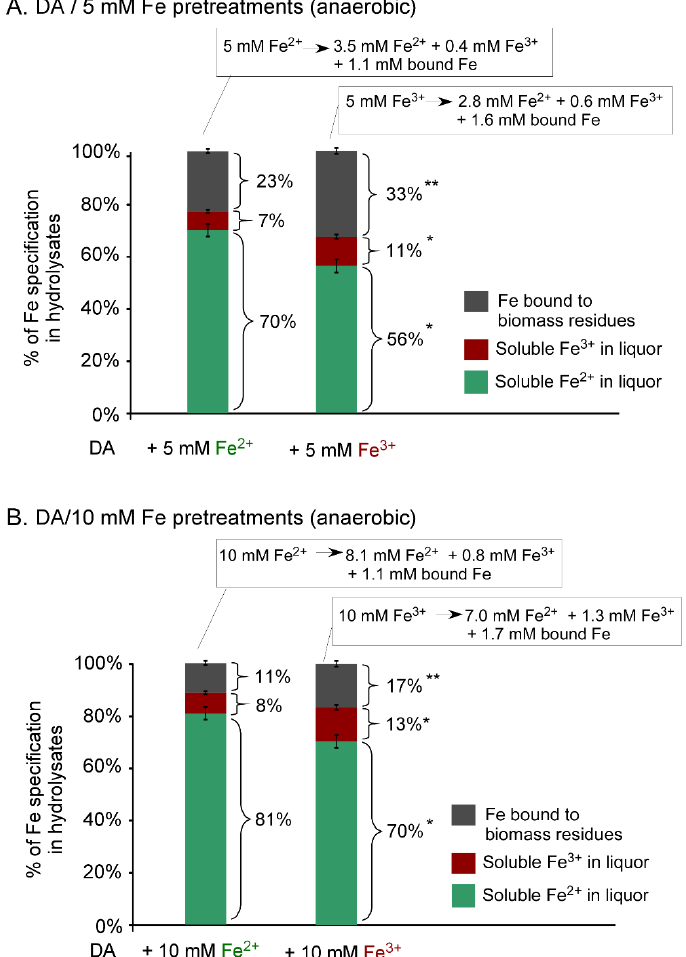
Figure 2. Fate of Fe in corn stover pretreated with either 5 or 10 mM Fe ions in dilute acid (0.5% H 2 SO 4 ) at 150 ◦ C for 20 min under anaerobic conditions. ( A ) Pretreatments of CS with DA / 5 mM Fe 2 + or Fe 3 + ions. ( B ) Pretreatments of CS with DA / 10 mM Fe 2 + or Fe 3 + ions. Soluble Fe 2 + or Fe 3 + were measured in the liquor after biomass pretreatment. The colors used in the bars: green for Fe 2 + and red for Fe 3 + in liquor; black for Fe bound to biomass residues. While the bars represent the percentage of Fe specification in the hydrolysates, the equations in each associated insert represent the valence and concentration of soluble Fe ions before and after the pretreatments. Asterisk indicates statistically significant di ff erence between Fe 2 + and Fe 3 + pretreatments (* for p < 0.05; ** for p < 0.01). CS, corn stover; DA, dilute